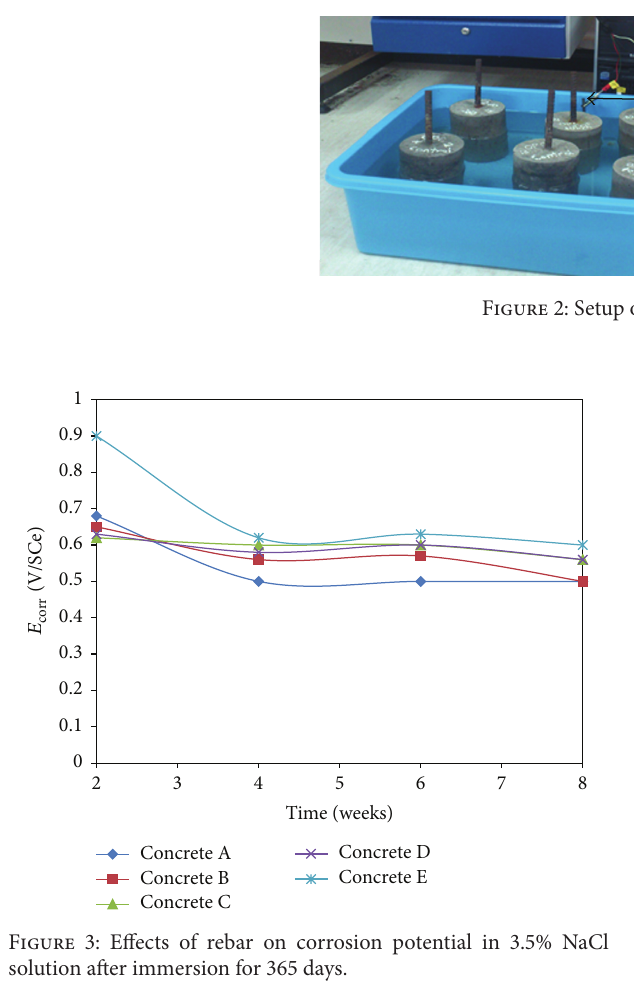
Figure 5: Corrosion rate of several types of concrete in 3.5% NaCl solution after immersion for 365